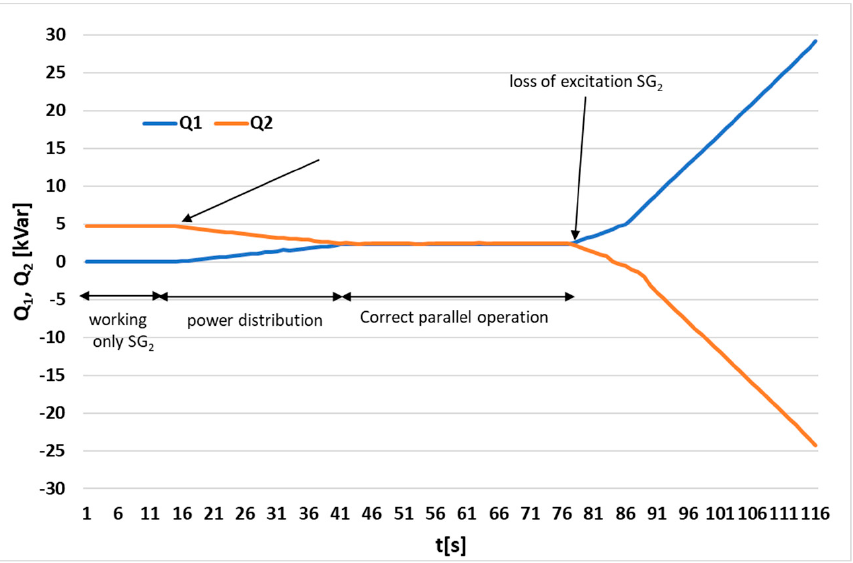
Figure 17. Waveforms of the reactive power (Q 1 and Q 2 ) obtained during the laboratory tests.